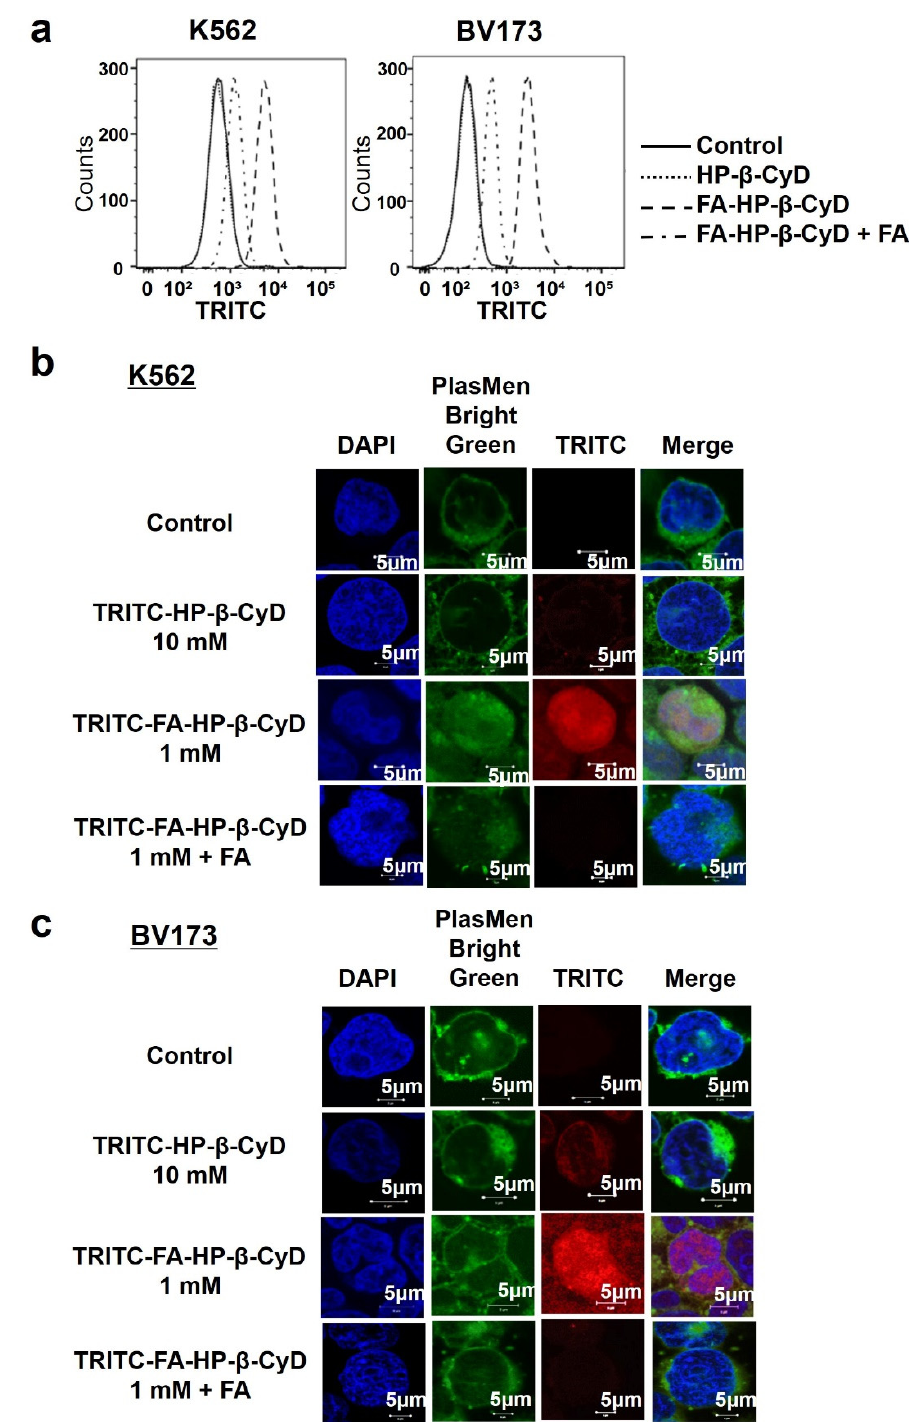
Figure 5. Intracellular distribution of FA-HP- β -CyD. ( a ) Cellular association of TRITC-FA-HP- β -Cy in K562 cells (left) and BV173 cells (right). The fluorescence intensity derived from TRITC was determined by flow cytometry at 1 h after incubation at 37 ◦ C. Control: medium only. ( b , c ) Intra- cellular distribution of TRITC-FA-HP- β -CyD. CML cells were treated with medium only (control), TRITC-FA-HP- β -CyD (1 mM), TRITC-FA-HP- β -CyD (1 mM) and FA (2 mM), or TRITC-HP- β -CyD (10 mM) for 1 h. The experiments were performed three times independently and representative images are shown.